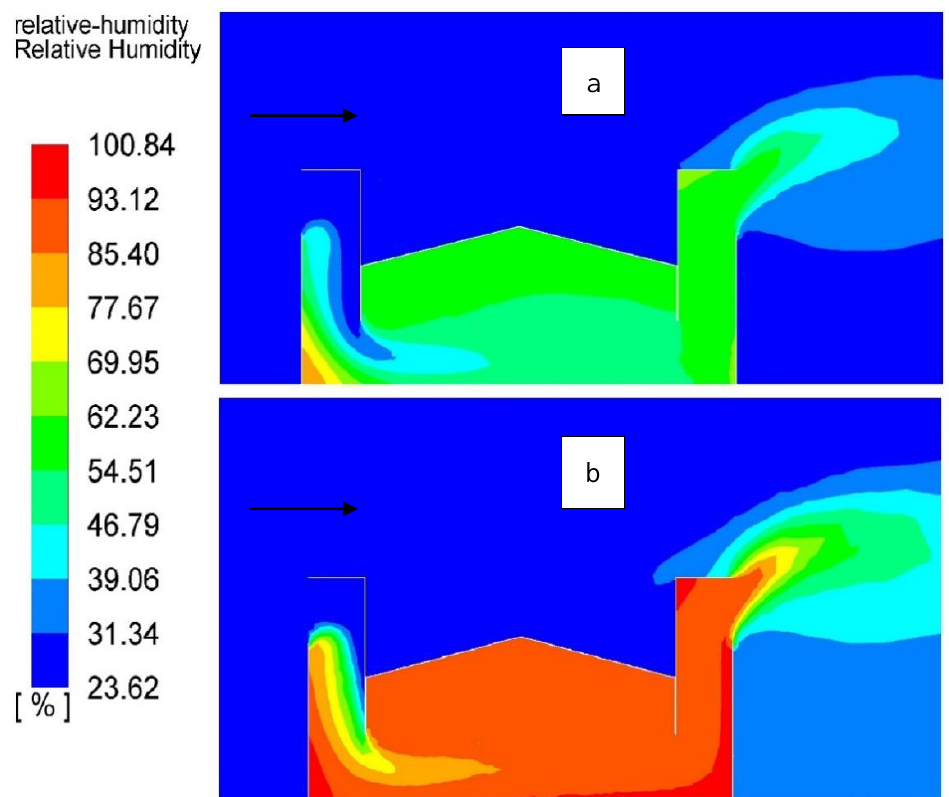
Figure 19. ( a ) Relative humidity contour at the midplane of the greenhouse—four parallel spray nozzles; ( b ) Relative humidity contour at the midplane of the greenhouse—eight parallel spray nozzles (ambient T = 40 °C, RH = 24.5%, U HWC = 4.4 m/s).